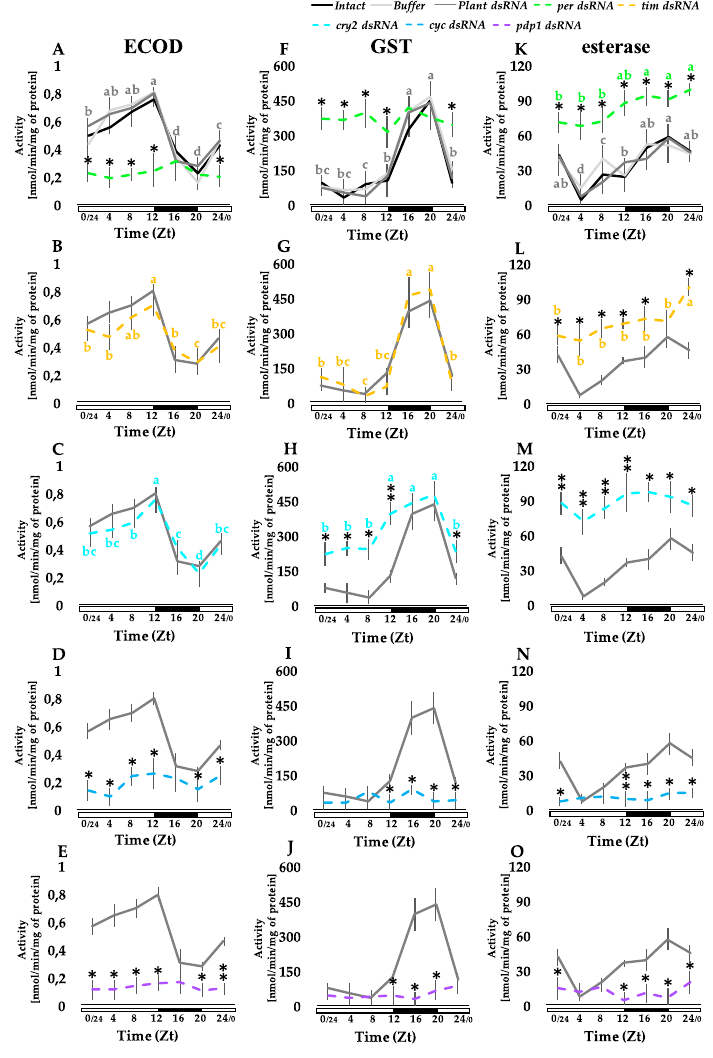
Figure 2. Changes of the daily patterns in the activity of xenobiotic metabolizing enzymes in the fat body caused by RNAi-mediated disruption of clock genes expression. The activities of ECOD ( A – E ), GST ( F – J ), and esterase ( K – O ) were analyzed in the fat body of the larvae whose molecular oscillator was altered by injection of clock genes dsRNA to their body cavity as in the experiment shown in Scheme 1C. For ECOD, GST, and esterase activities, data are expressed as the amount of 7-hydroxycoumarin, glutathione conjugate, and α -naphthol formed, respectively, per minute and per milligram of protein in the samples. Graphs in the first row show the effects of RNAi in insects injected with per dsRNA (green dashed lines) with comparison to controls: insects that were untreated (Intact—black lines), injected with a transcription buffer (Buffer—light gray lines), and injected with SSU dsRNA (Plant dsRNA—dark gray lines). Injection effects of dsRNA of other clock genes are presented in the subsequent rows: tim (orange dashed lines on graphs in the second row), cry2 (turquoise dashed lines on graphs in third row), cyc (light blue dashed line on graphs in fourth row), and pdp1 (purple dashed line on graphs in fifth row); for clear presentation, these results are shown only against the same data, repeatedly plotted on graphs, which were received for insects injected with SSU dsRNA. Values with different letters differ significantly ( p < 0.05), as calculated by an ANOVA and Bonferroni post-test for data of the Intact group. Significant differences between mean values for larvae treated with clock gene dsRNA and from control groups at a given time point were calculated by an ANOVA and unpaired t -test. Comparisons between the groups treated with the dsRNA of the clock genes and the plant dsRNA, with * p < 0.05 and ** p < 0.01 are shown. White and black horizontal bars, and Zt defining the time, are the same as in Figure